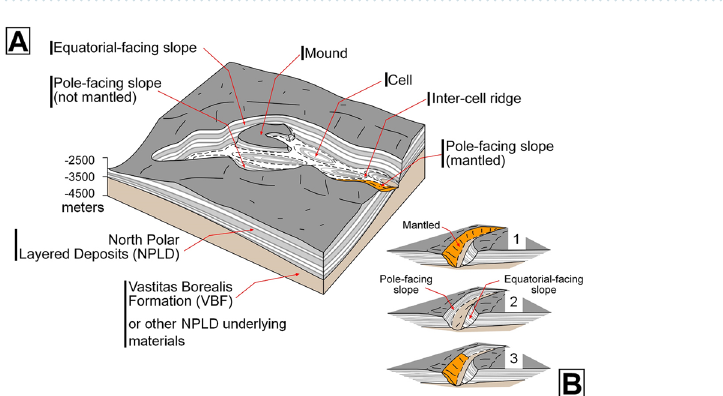
Figure 2. ( A ) Close-up view centered at 85° 10’ N, 110° 59’ W on a PB trough section. The dashed black lines trace the outlines of several individual cells. See Fig. 1A for context and location. The image is a color MOLA digital elevation model (512 pixels/degree, credit: MOLA Science Team, MSS, JPL, NASA) draped over part of a CTX mosaic (6 m/pixel, credit: NASA/JPL. The license terms can be found at pds-imaging.jpl.nasa.gov/ portal/mro_mission.html). ( B ) Close-up view on panel ( A ). The dashed white line identifies a group of layers bounding two cells. The layers have equator and pole-facing exposures. The elevation profile (extracted from the MOLA DEM) shows that the trough’s total relief (~ 800 m) is bounded by these layers (red dots in panels A and B identify outcrops). ( C ) Close-up view on panel ( B ). View shows examples of layers along the margins of a cell partly nested between a layered mound and the trough’s equator-facing slope, which clearly demonstrate a truncation origin. The panels are parts of a CTX mosaic (6 m/pixel, credit: NASA/JPL. The license terms can be found at pds-imaging.jpl.nasa.gov/portal/mro_mission.html). We produced this figure using Esri’s ArcGIS 10.3 (http:// www. esri. com/ softw are/ arcgis).